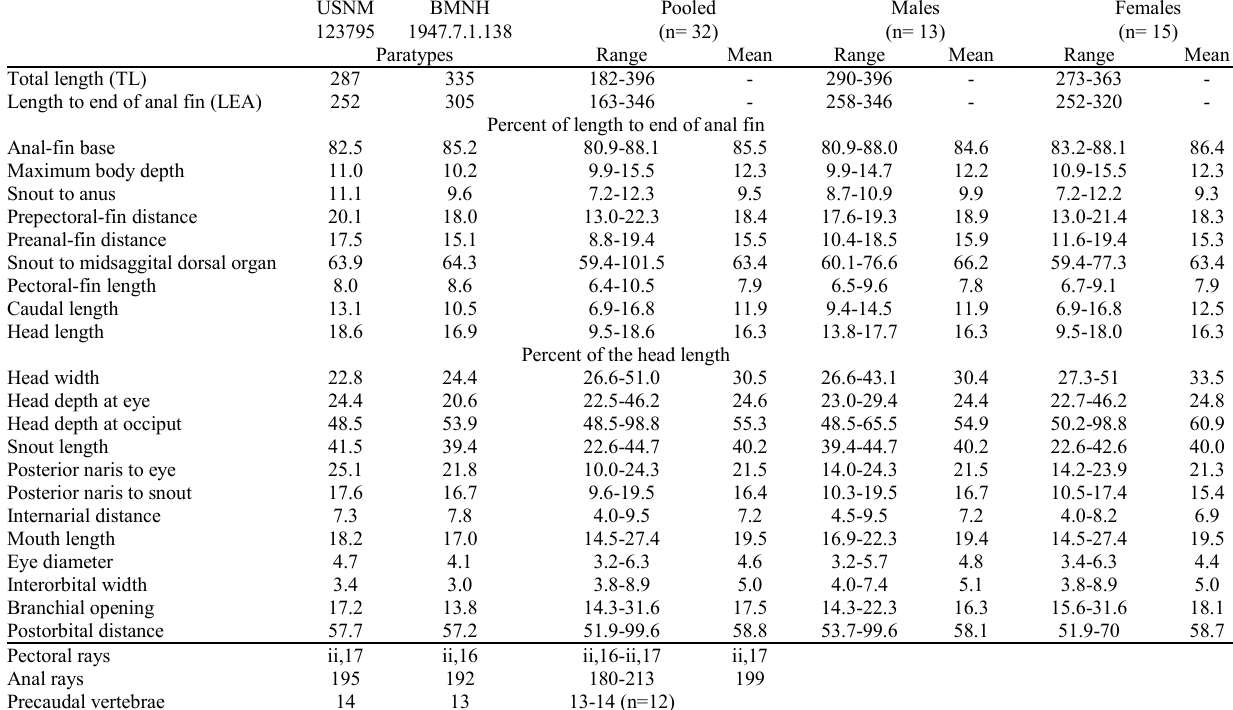
Table 1. Morphometric and meristic data for Apteronotus magdalenensis . Pooled = 32 non-types combined.